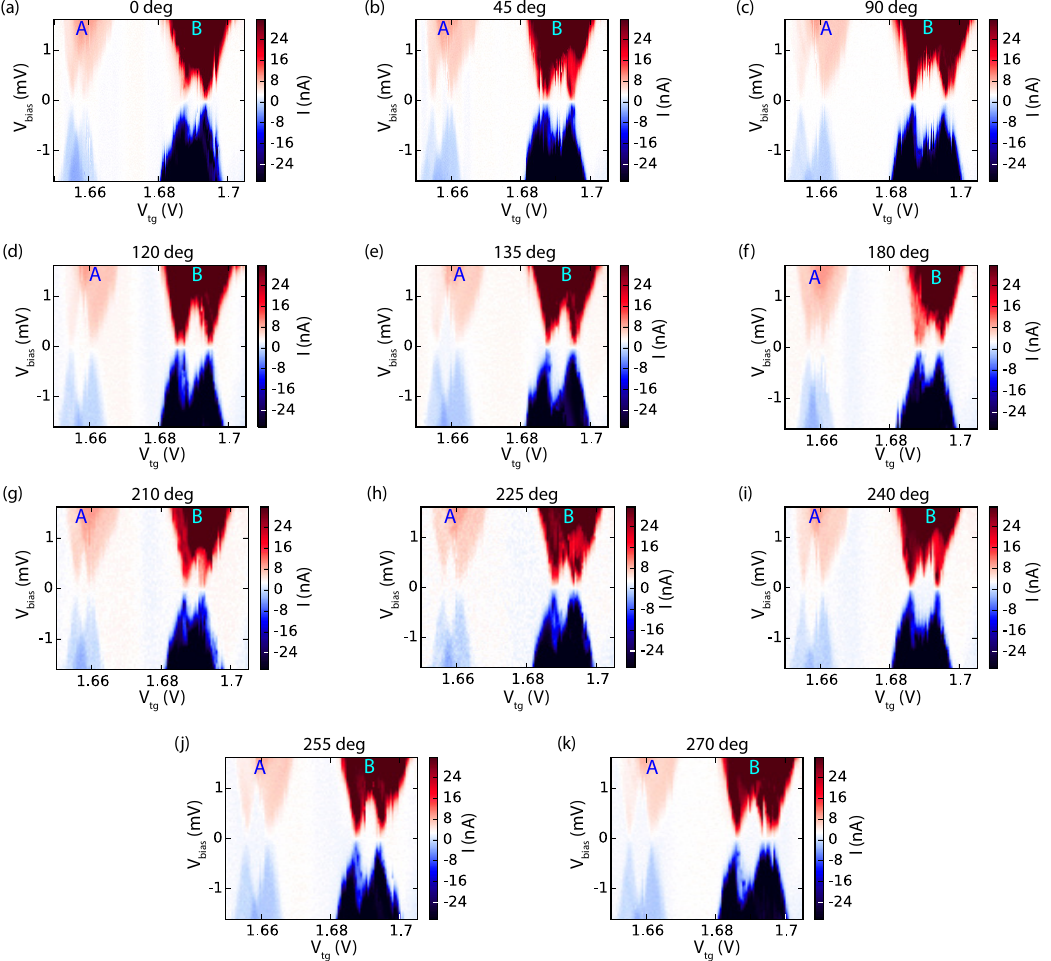
Figure S5: Measurements of current as function of V ent panels correspond to different magnetic field orientations indicated above each panel with respect to the nanowire axis. The magnetic field amplitude is 1 Tesla. States A and B are labeled. Global backgate voltage is zero.